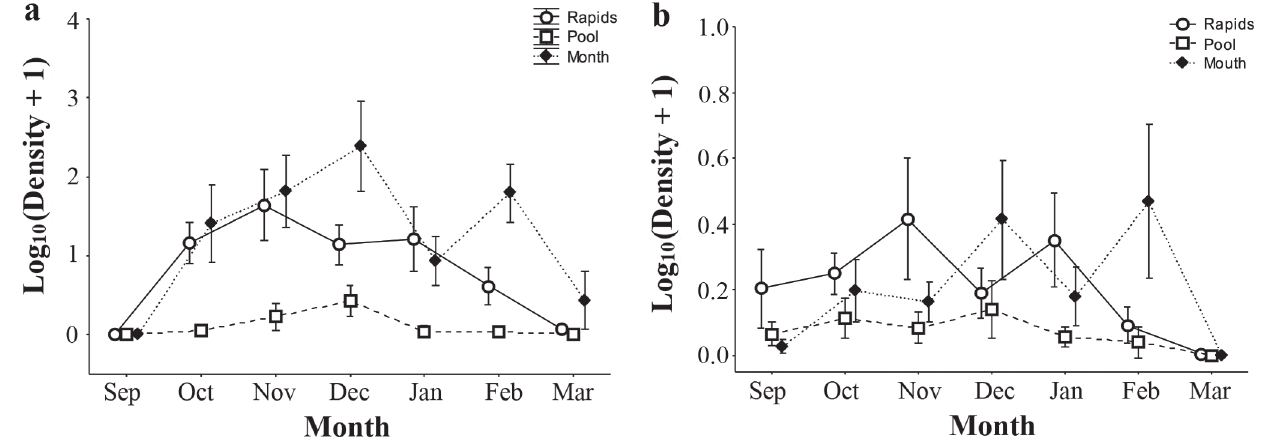
Fig. 4. Average densities (± standard error) of the eggs ( a ) and the larvae ( b ) in the sampling sites of Ligeiro River between the months of September 2006 and March 2007.